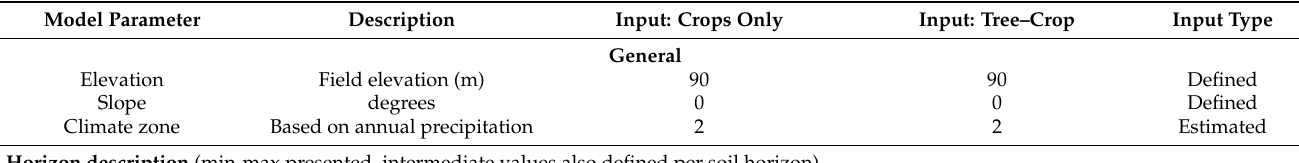
Table 2. Model input